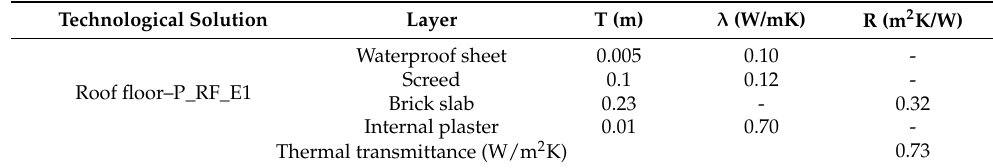
Table A5. Existing roof floor stratigraphy (P_RF_E1).